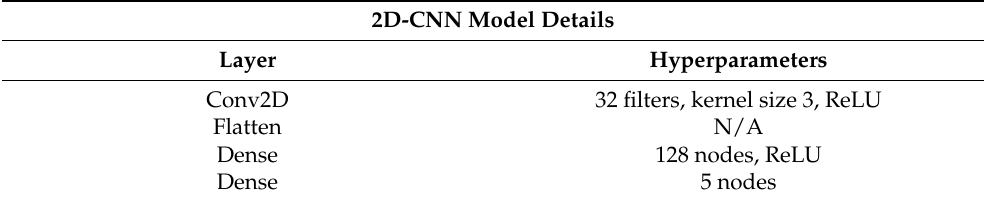
Table 1. The hyperparameters of the 2D-CNN model. Any values not specified are left as the default settings for each